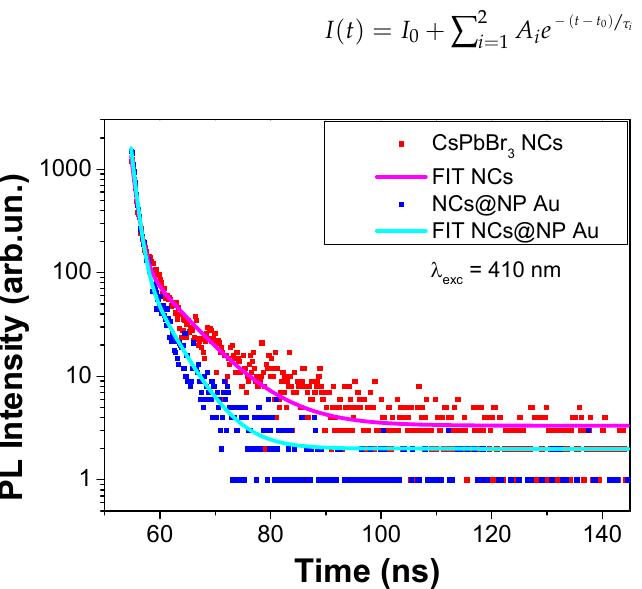
Figure 10. Time-resolved photoluminescence measurements of pure CsPbBr 3 NCs and the NCs–NP Au hybrid structure; λ exc = 410 nm.